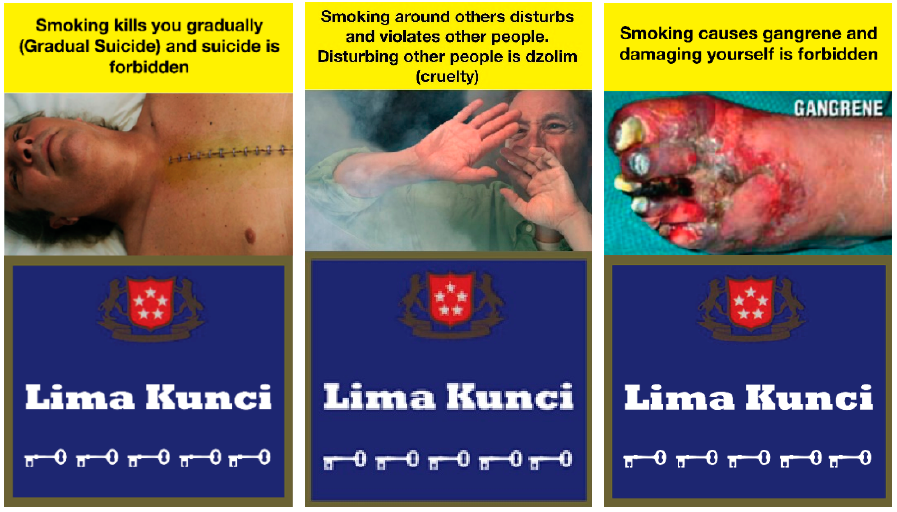
Figure 1. Religious Health Warning Labels.